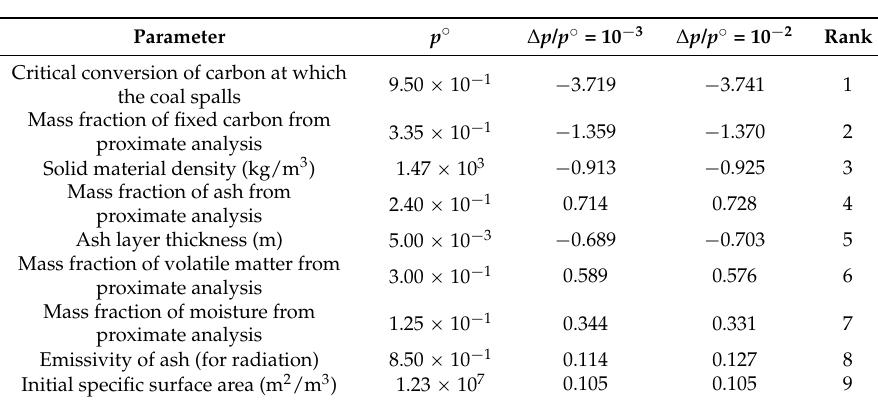
Table 19. Sensitivity of the cavity growth rate to changes in coal properties